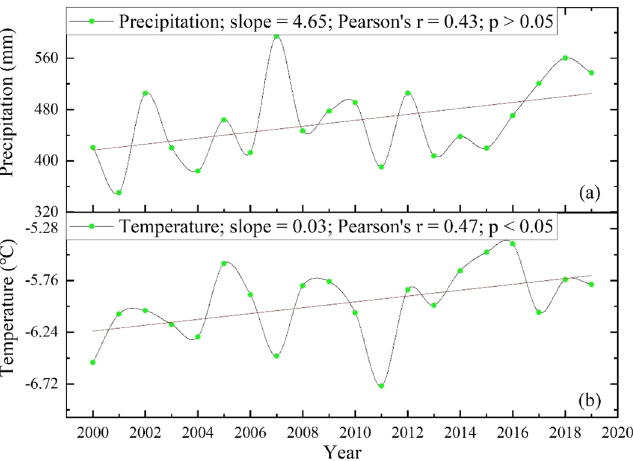
Figure 9. Variation in precipitation ( a ) and temperature ( b ) in the grasslands of Qilian County during the 2000–2019